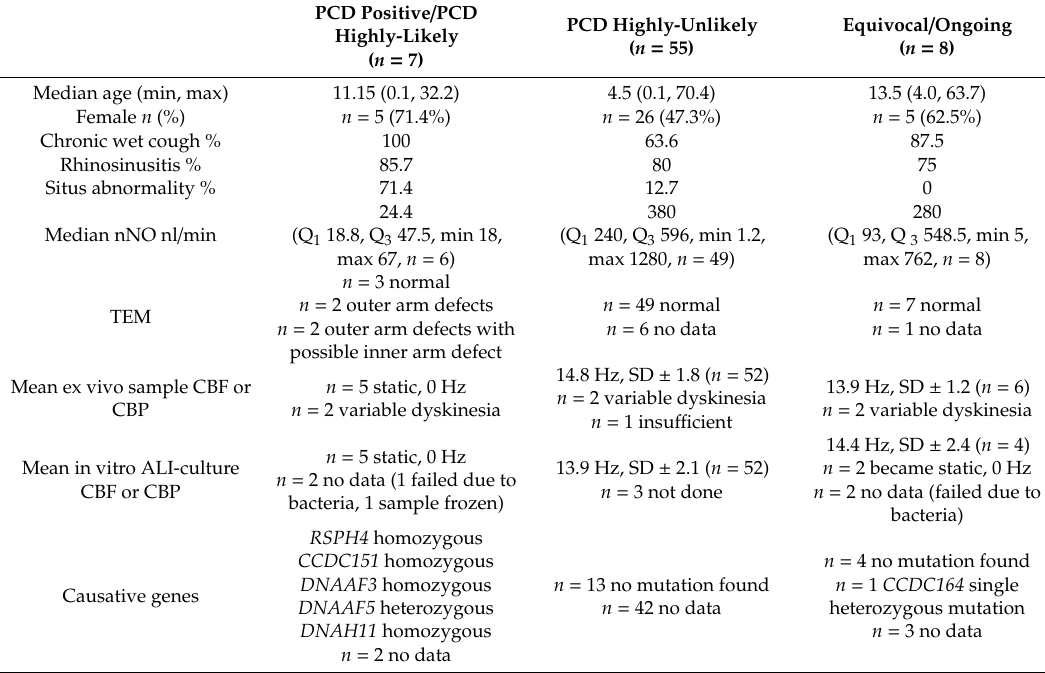
Table 1. The characteristics of subjects referred for diagnostic testing to University Hospital Southampton primary ciliary dyskinesia (PCD) centre 1st April 2018 to 1st April 2019, grouped by final multidisciplinary team (MDT) diagnostic